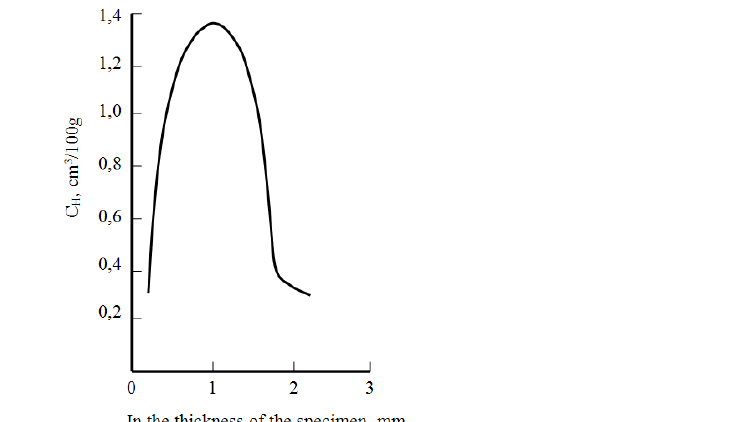
Figure 1 : Hydrogen distribution C through the thickness for the hydrogen-charged specimen at the distance of 30 m  from the H crack tip ( 20 K  mMPa ). max